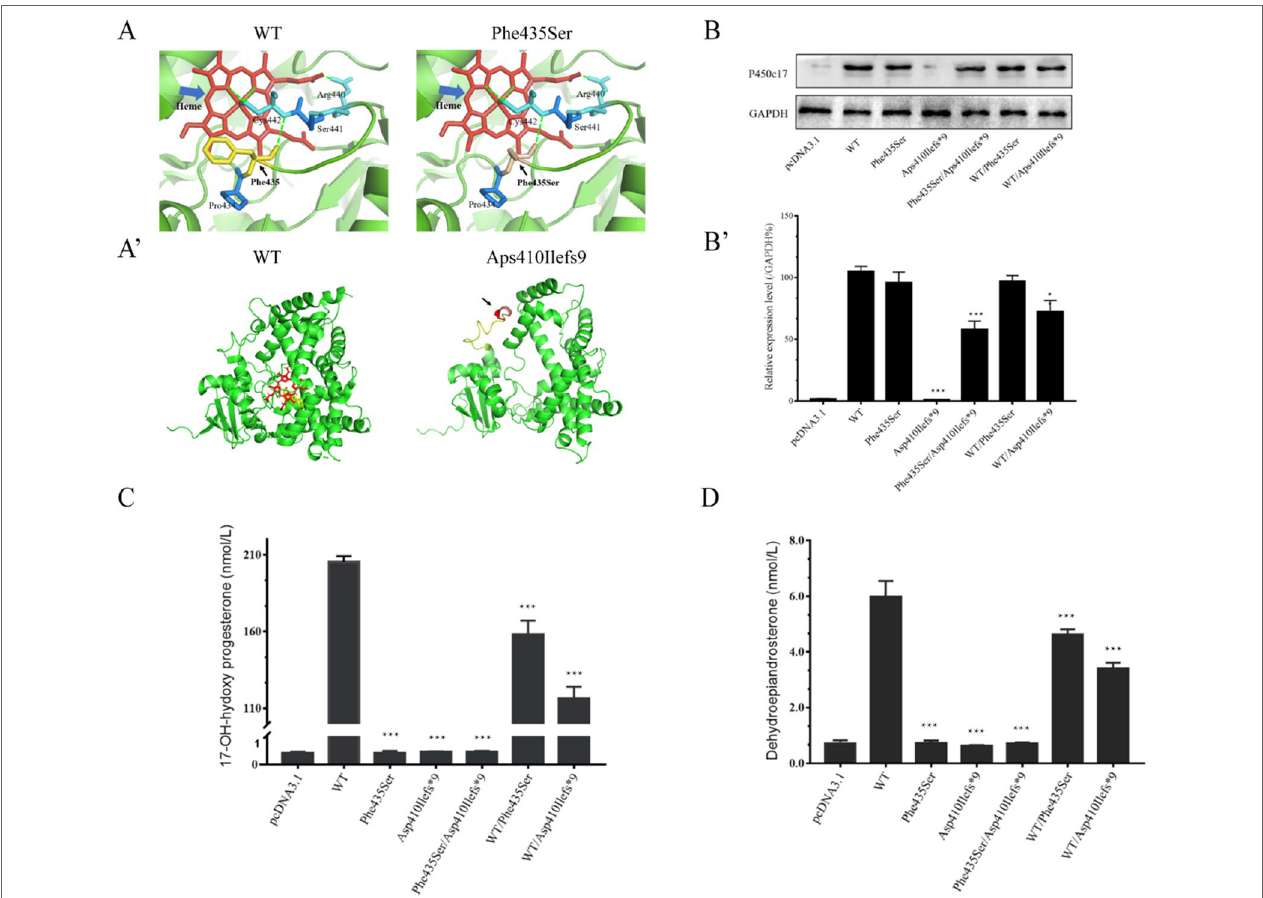
FigURe 3 | Structural and functional analysis. (A , A’) Three-dimensional structure as predicted by the Swiss-Pdb Viewer program. (A) Phe435 interacts with Cys442 through hydrogen bonds. The conversion of nonpolar phenylalanine into polar serine will disturb the hydrophobic environment. Heme is shown in red, and hydrogen bonding with a green dot. (A’) The p.Asp410Ilefs*9 frameshift variant resulting in a truncated protein. (B) Western blotting analysis of P450c17 from HEK-293T transfected cell lines. Glyceraldehyde 3-phosphate dehydrogenase (GAPDH) is shown as a loading control. (B’) Quantified analysis of Western blotting of P450c17. (C , D) Enzymatic activity assays of 17-hydroxylase and 17,20-lyase from HEK-293T transfected cell lines. (C) The production of 17-hydroxyprogesterone (17-OHP) in the presence of progesterone is indicated as a measurement of 17-hydroxylase activity. (D) The production of dehydroepiandrosterone (DHEA) in the presence of 17-hydroxypregnenolone is indicated as a measurement of 17,20-lyase activity. Data are expressed as mean ± standard deviation (SD) ( n = 3). * p < 0.1, ** p < 0.01, *** p < 0.001.